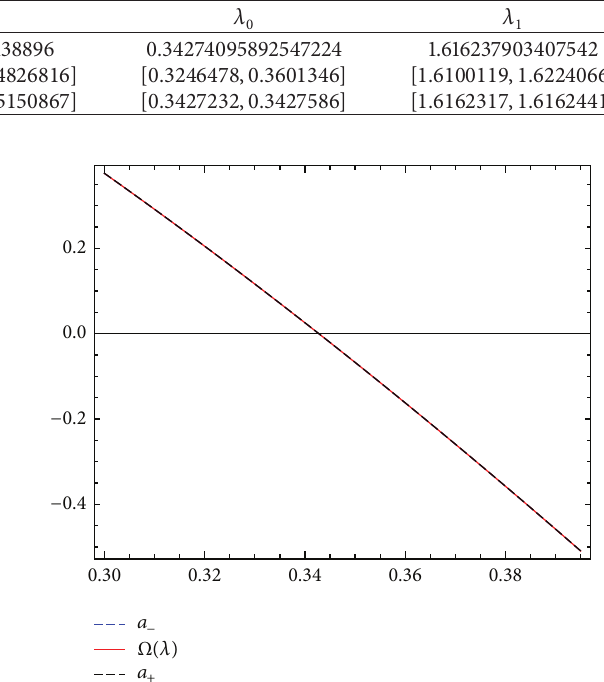
Table 3: For 𝑁 = 25 and ℎ = 0.1 , the exact solutions 𝜆 𝑘 are all inside the interval [𝑎 − , 𝑎 + ] for different values of 𝜀 .